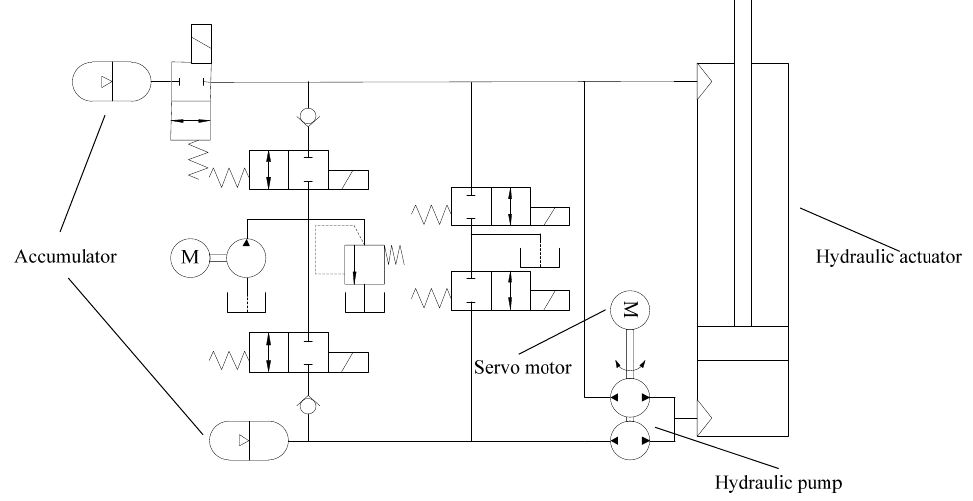
Figure 3. The schematic diagram of the direct drive hydraulic system adopted in this paper .